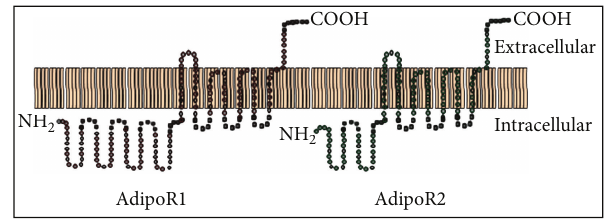
Figure 1: Structure of adiponectin receptors—AdipoR1 and Adi- poR2 (66.7% amino acid